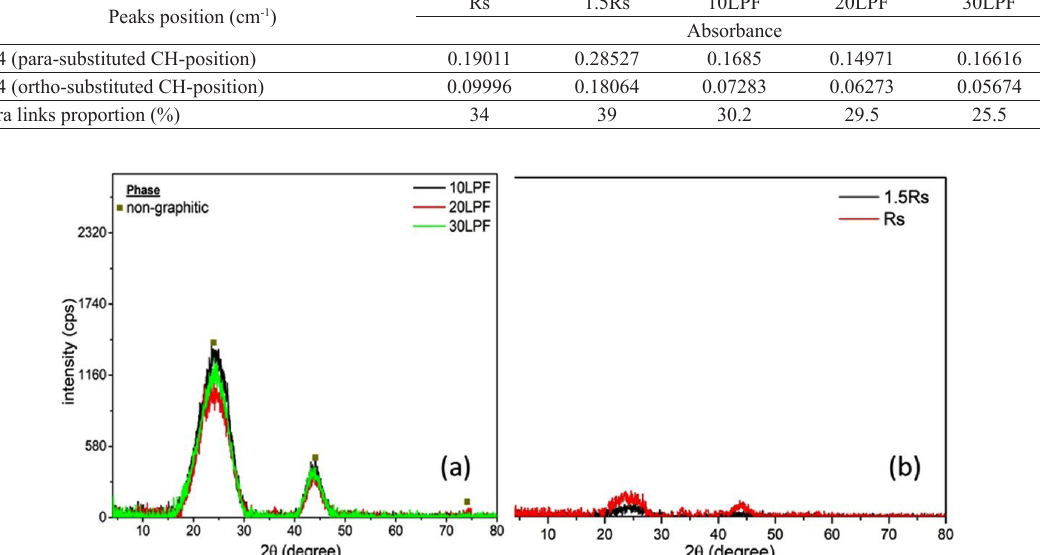
Figure 4. Diffractograms of lignin-phenol-formaldehyde resins carbons after pyrolysis at 1000 ºC/5h. LPF = lignin-phenol-formaldehyde resin, 1.5Rs = laboratory synthesized resole based on 1.5 formaldehyde to phenol molar ratio, Rs = commercial resole